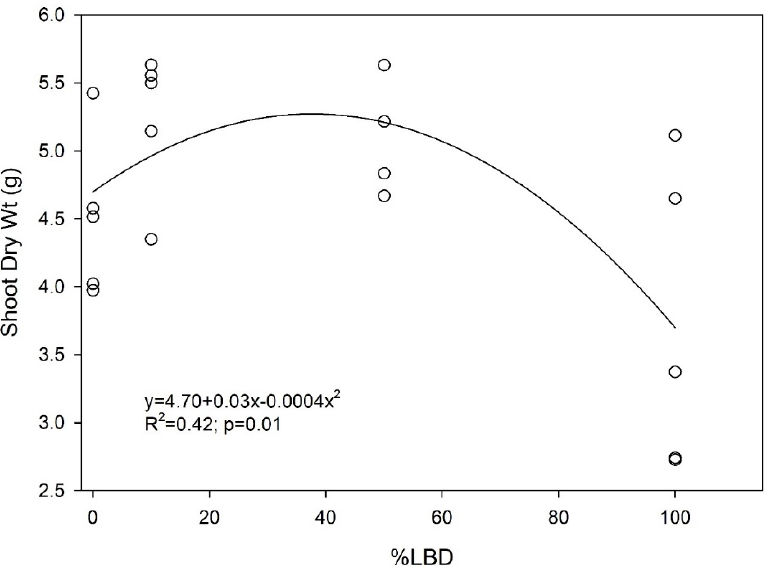
Figure 2. Regression curve for greenhouse-grown kai choy shoot dry weight with increasing LBD at the 100% N